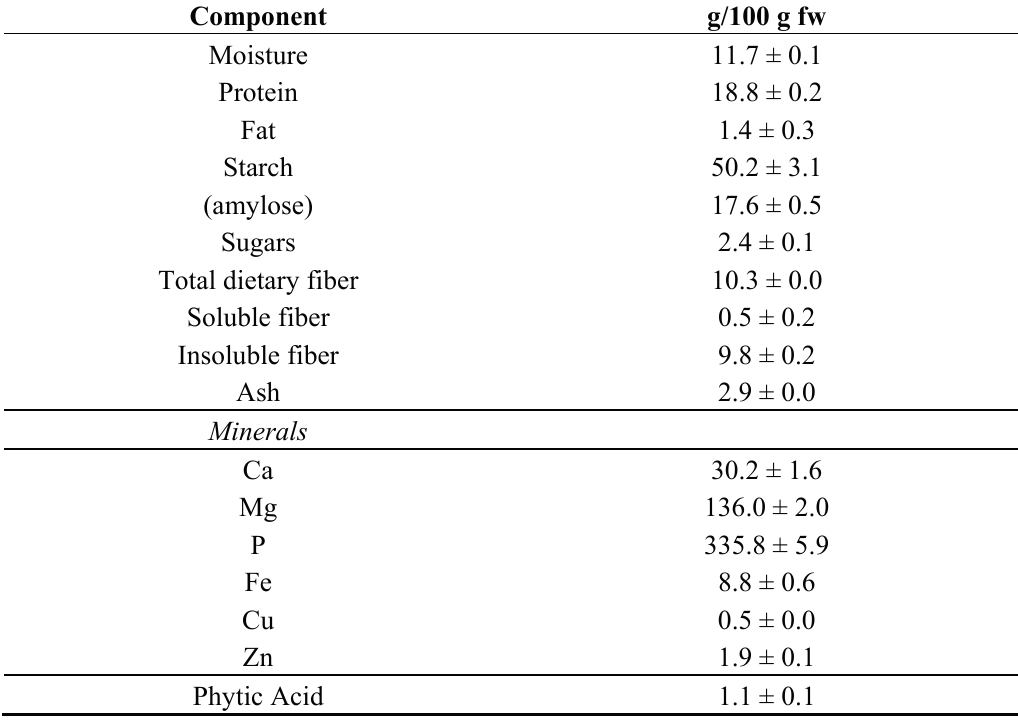
Table 1. Proximate composition, minerals and phytic acid contents of Bambara groundnut a